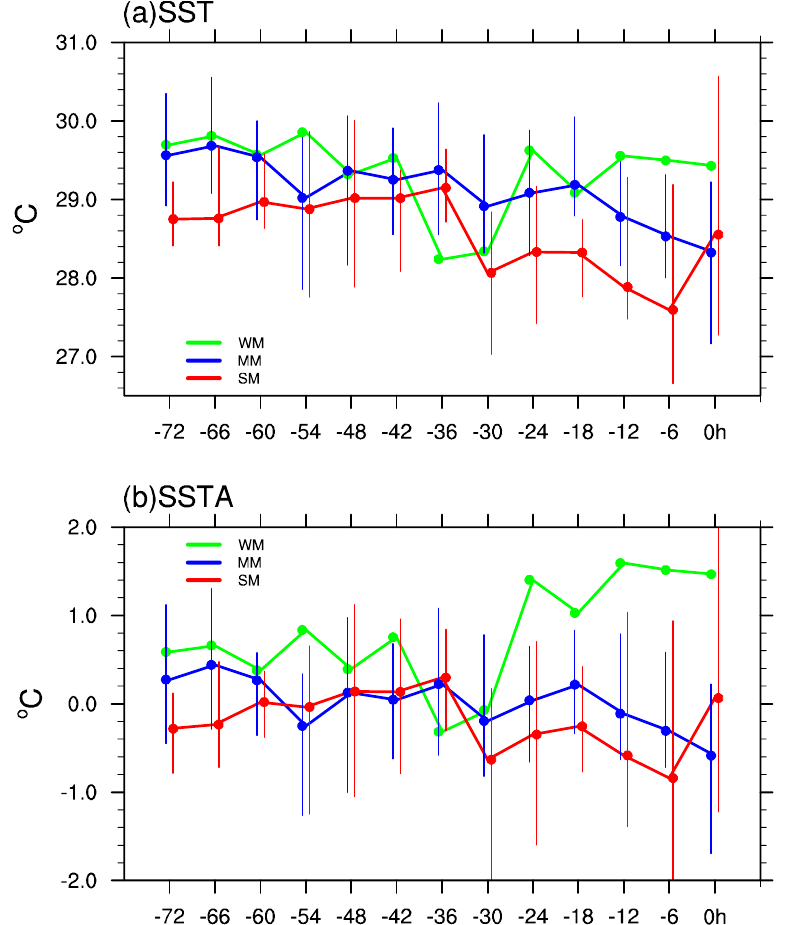
Figure 9. Temporal evolutions of the SST ( a ) and SSTA ( b ) in typhoon center for three clusters from 72 h before landfall to landfall. Vertical bars are the range temperature among each cluster. Units: ◦ °C .